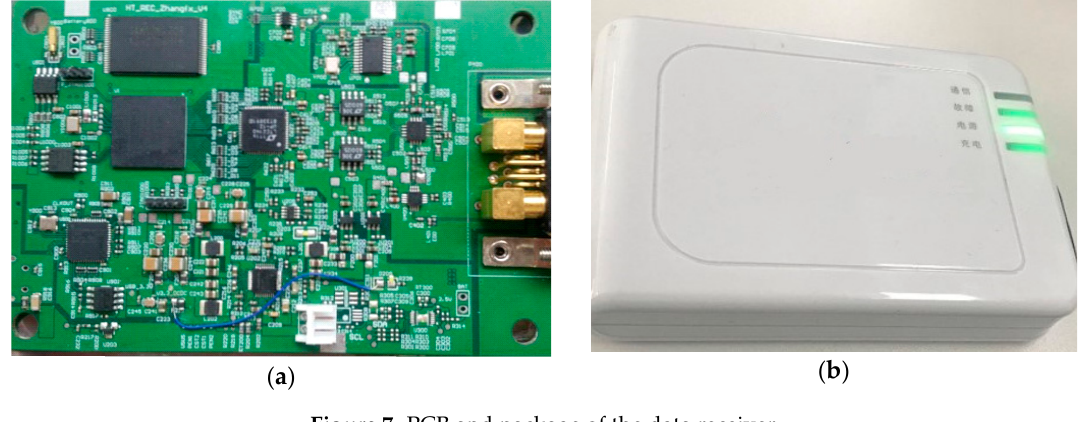
Figure 7. PCB and package of the data receiver.